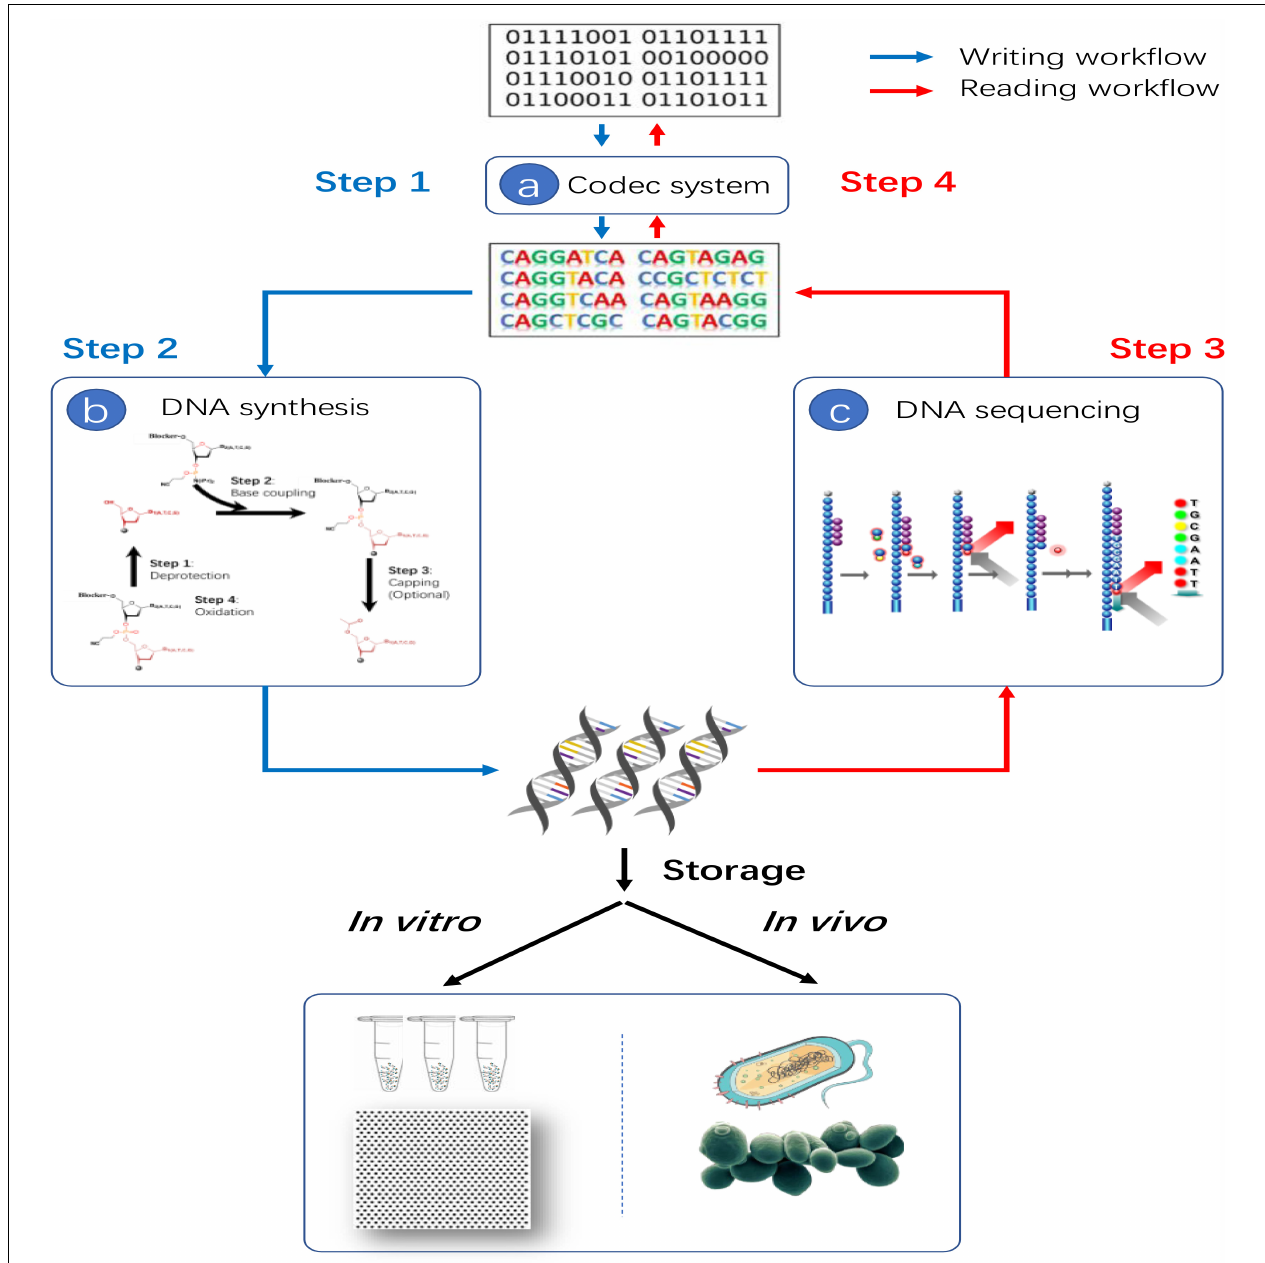
FIGURE 4 | Basic principle of data storage in DNA. Three key technologies are required: (a) Codec technology which can encode binary string into DNA string and decode DNA string back to binary string. (b) DNA synthesis technology for the actual data writing process. (c) DNA sequencing technology for data reading process.